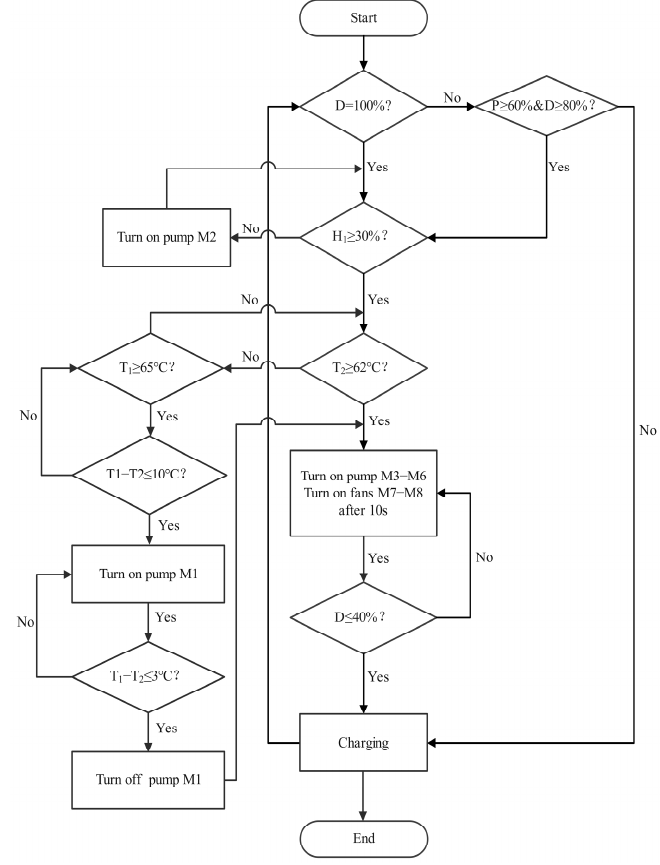
Figure 21. The control flowchart.